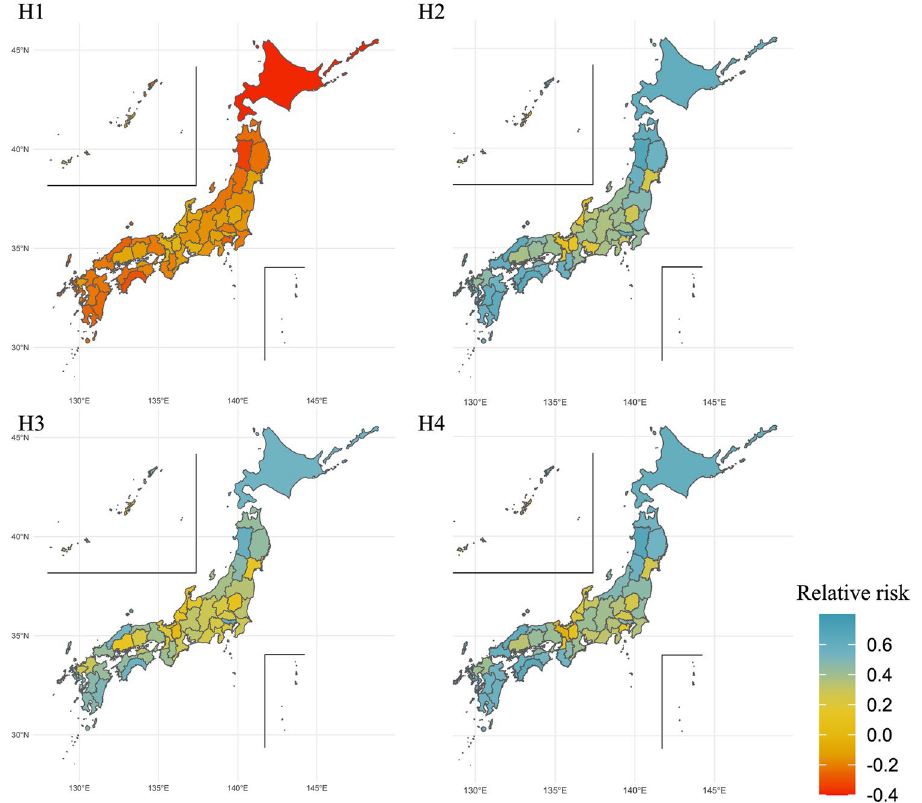
Figure 2. Estimated relative risks by hypothetical scenarios: (H1) no travel restriction scenario, (H2) lockdown- based scenario, (H3) delete the top 10 populous passenger volumes edges scenario, and (H4) restriction of airplane travel